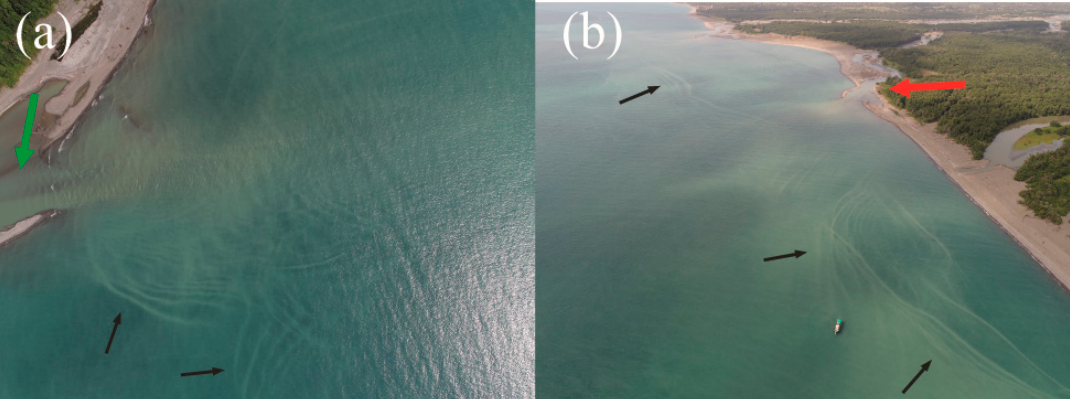
Figure 10. Aerial images of surface manifestations of low-frequency internal waves within the Kodor plume near the mouths of ( a ) the northern and ( b ) the central deltaic branches on 2 September 2018. The green arrow indicates location of the northern deltaic branch of the Kodor River and the red arrow indicates location of the central deltaic branch of the Kodor River. Black arrows indicate surface manifestations of internal waves.